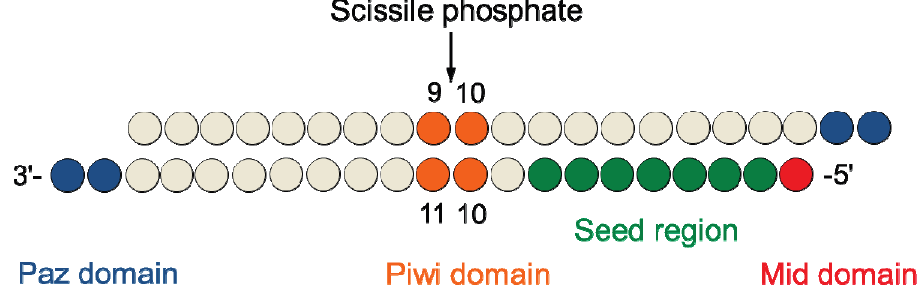
Figure 2. Schematic representation of a 21-mer siRNA duplex. The upper strand is the sense ( SS ), the lower strand is the antisense ( AS ) that guides the cleavage of the cognate mRNA. Only one of the two strands is retained into the Ago2 protein (the antisense), the sense strand is cut and